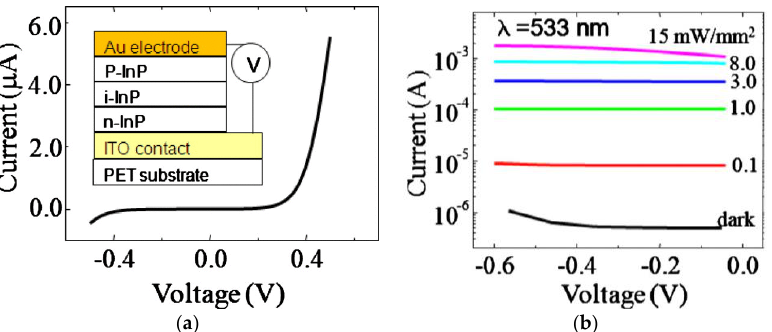
Figure 15. Measured flexible InP p-i-n PD characteristics. ( a ) Measured dark current-voltage characteristics. ( b ) Measured photocurrents at different incident optical powers for a 533-nm wavelength light source (reprinted from [41]).